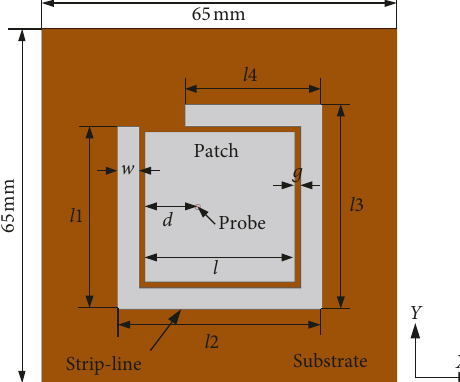
Figure 1: The geometries of the designed CP microstrip